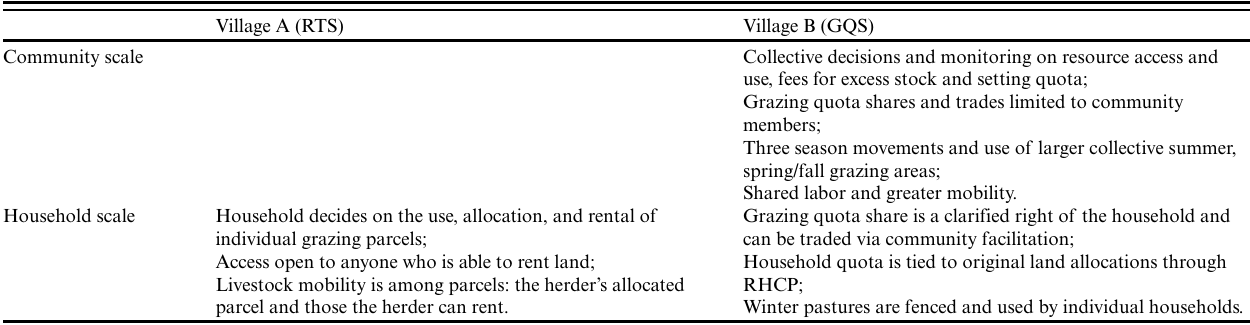
Table 3 . Scale and grazing management institutions. Note: RTS = rangeland transfer system, GQS = grazing quota system, RHCP = rangeland household contract policy.